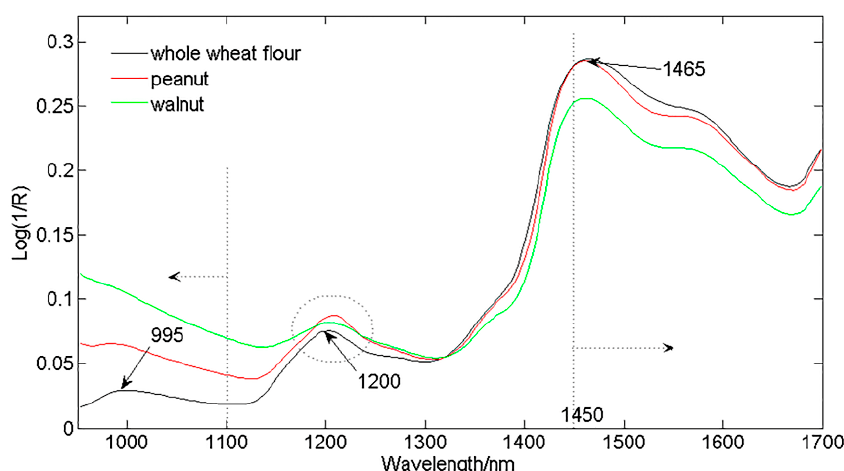
Figure 1. Average absorbance spectra of pure whole wheat flour, peanut powder, and walnut powder.